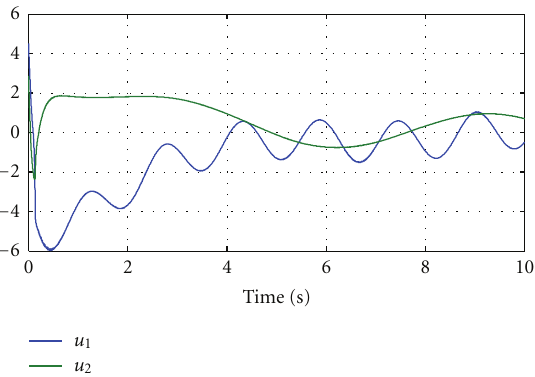
1 for Example 6.